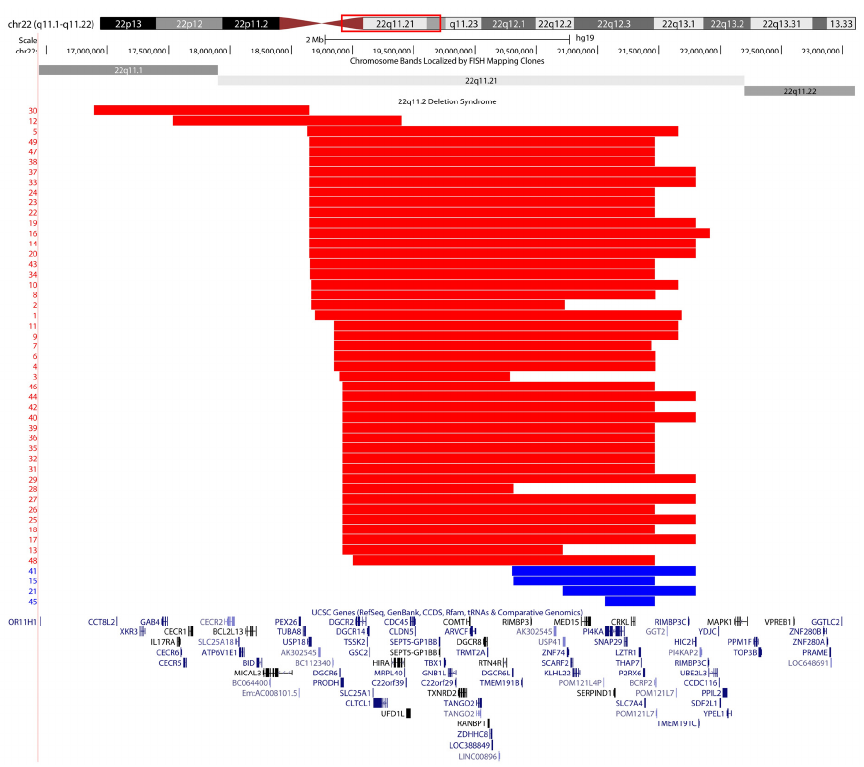
Figure 1. Genomic region of the 22q11.2DS deletions; those with methylation episignature are depicted in red, and the cases showing no episignature in blue. Case 30 does not overlap in coordinates with other cases that exhibit an episignature; however, this patient carries an additional 53 Mb duplication of chromosome 13 and therefore cannot be considered as simply 22q11.2DS. Cytogenetic bands and known genes are presented in this figure using the UCSC genome browser (http://genome.ucsc.edu accessed on 5 August 2021) 2009 (GRCh37/hg19) genome build (Kent